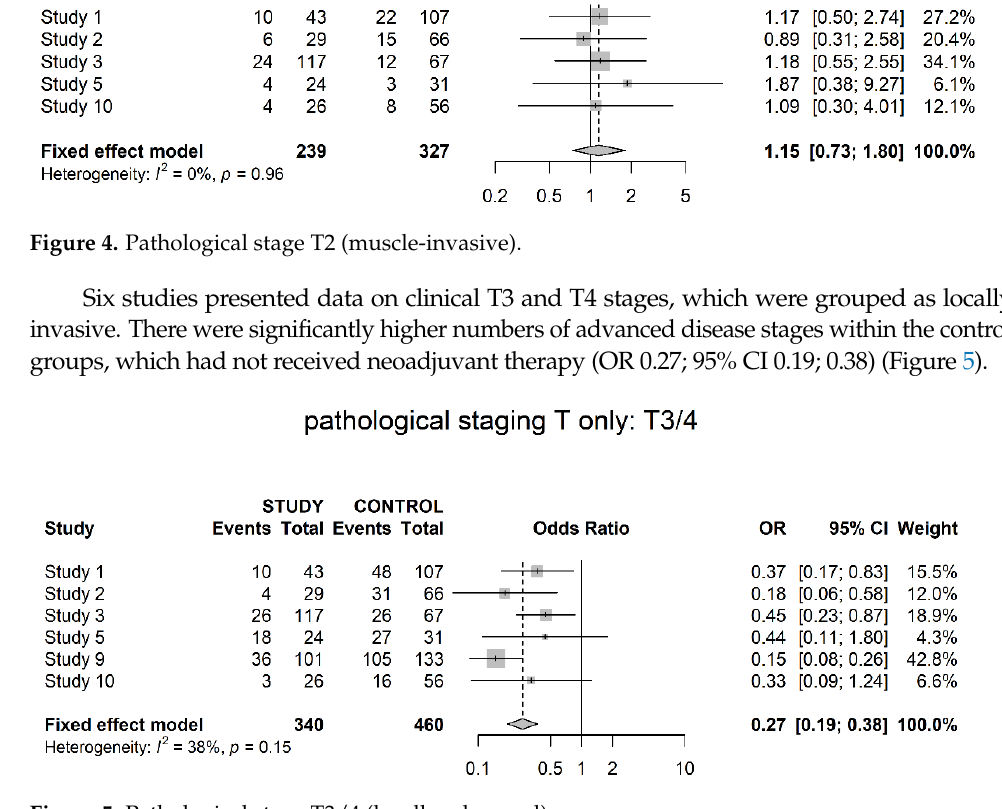
Figure 5. Pathological stage T3/4 (locally advanced).